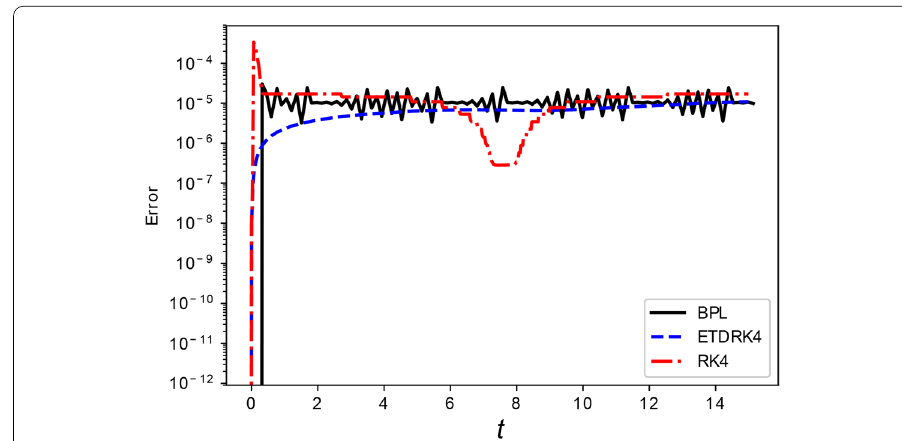
Fig. 15 Korteweg de Vries equation. Evolution of the error with time